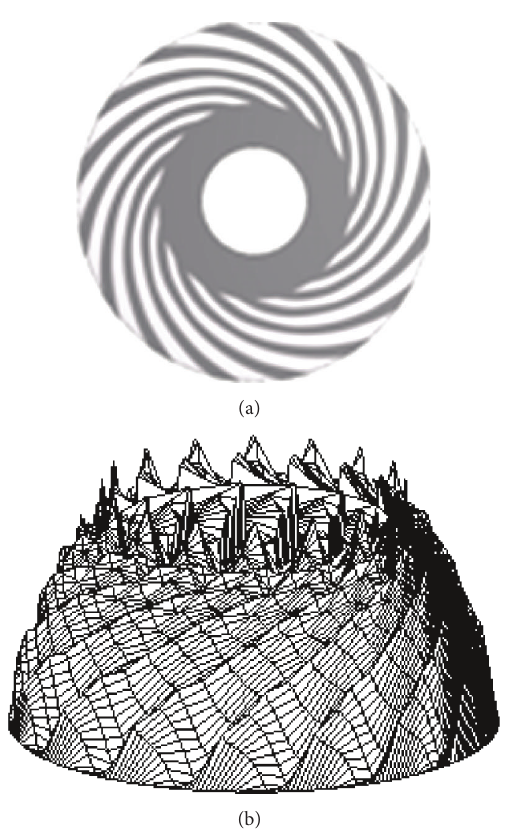
Figure 2: Initial spiral thrust bearing groove geometry and pressure distribution; (a) groove geometry, (b) pressure distribution.